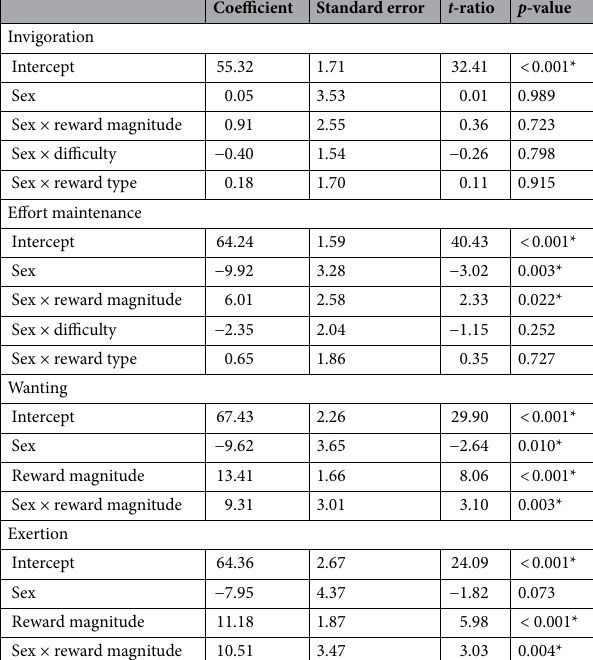
Table 2. Estimates of mixed-effects models. Variables were coded as follows: sex (male = 0, female = 1), reward magnitude (low = 0, high = 1), difficulty (low = 0, high = 1), reward type (money = 0, food = 1). P -values with an asterisk indicate